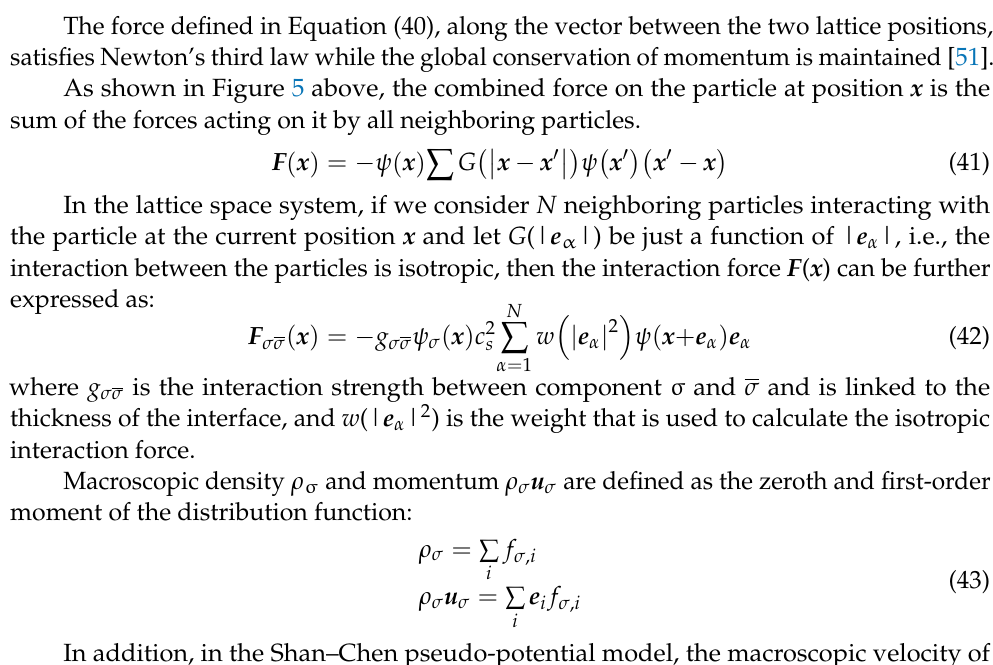
Figure 5. The principle of the pseudo-potential model: ( a ) the schematic of the drop–interface–matrix structure; ( b ) the pseudo-potential force between particles at the interface.